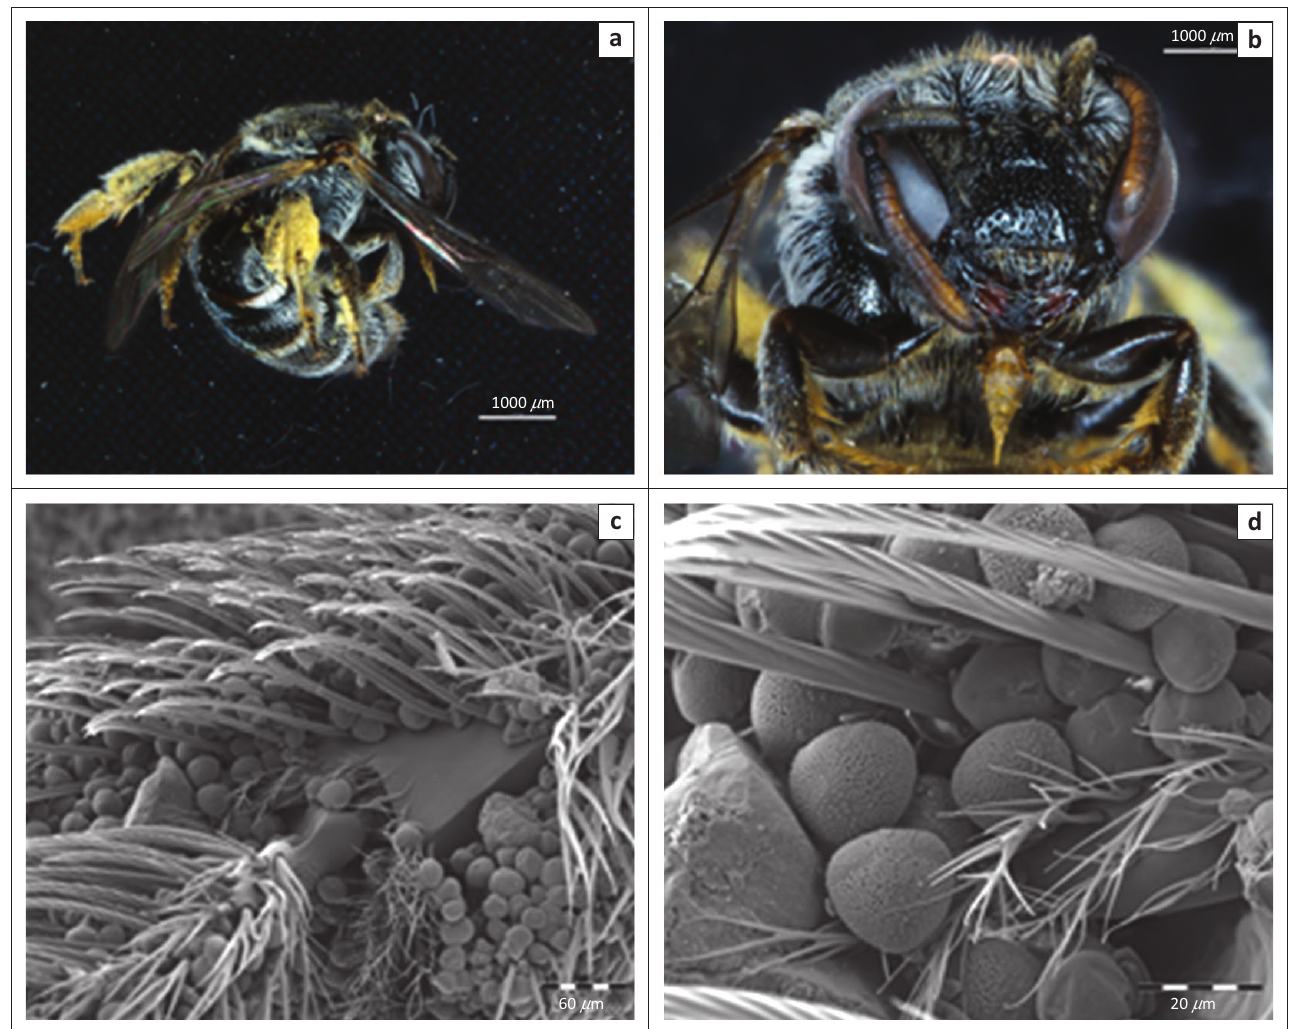
FIGURE 9: (a, b) Stereomicrograph of Lipotriches sp. (Halictidae). (c, d) Scanning electron micrographs of Frithia humilis pollen grains in the pollen